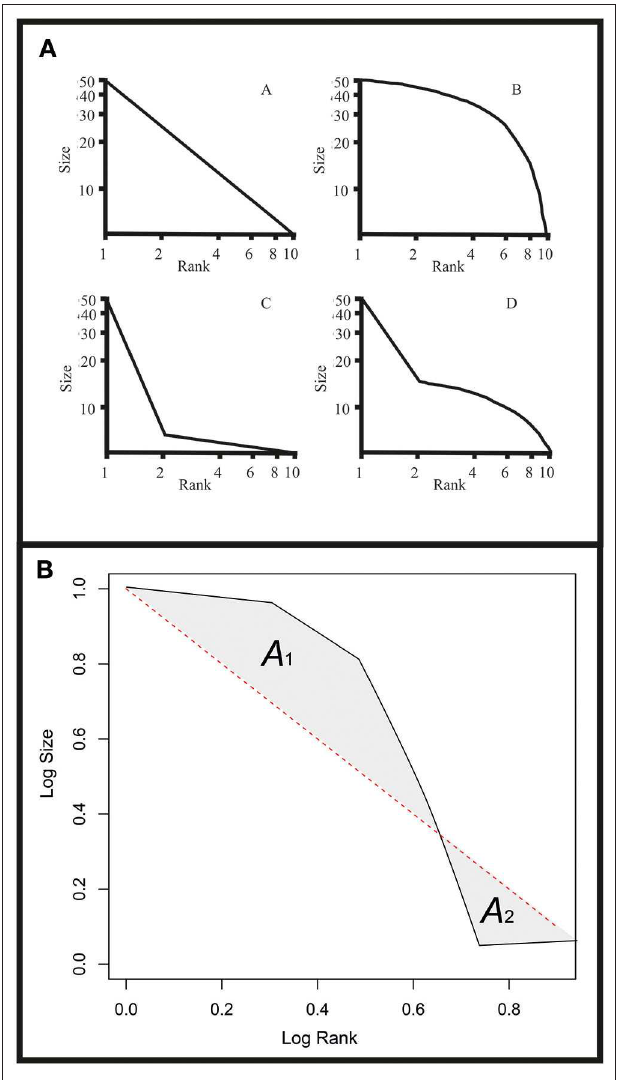
FIGURE 3 | (A) Different types of Rank size curve. (A) Log normal Zipfian. (B) Convex. (C) Primate. (D) Primo convex. (B) Areas in a rank-size graph used as positive (A1) and negative (A2) components of the coefficient A. The red dashed line indicates the